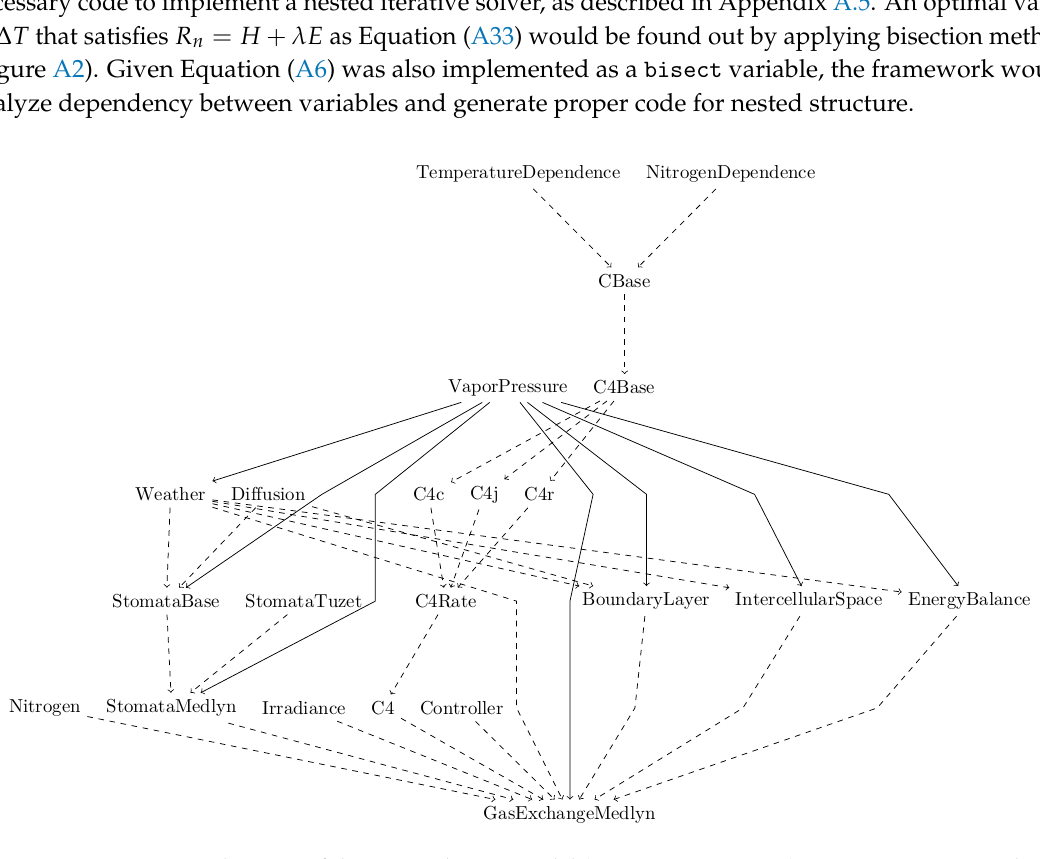
Figure A1. System diagram of the gas-exchange model ( GasExchangeMedlyn ) incorporating several submodels including Medlyn stomatal conductance model implemented on Cropbox framework. Solid arrow indicates ‘has’ relationship that the entity pointed out by the arrow owns the other entity and takes responsibility of state updates. Dashed arrow indicates ‘is’ relationship that the pointing entity becomes a trait of the other entity at the